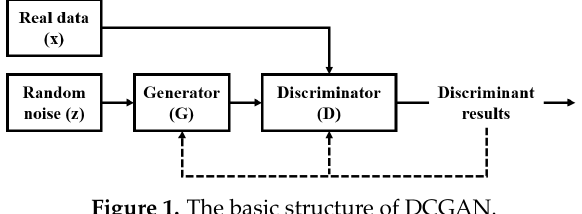
Figure 1. The basic structure of